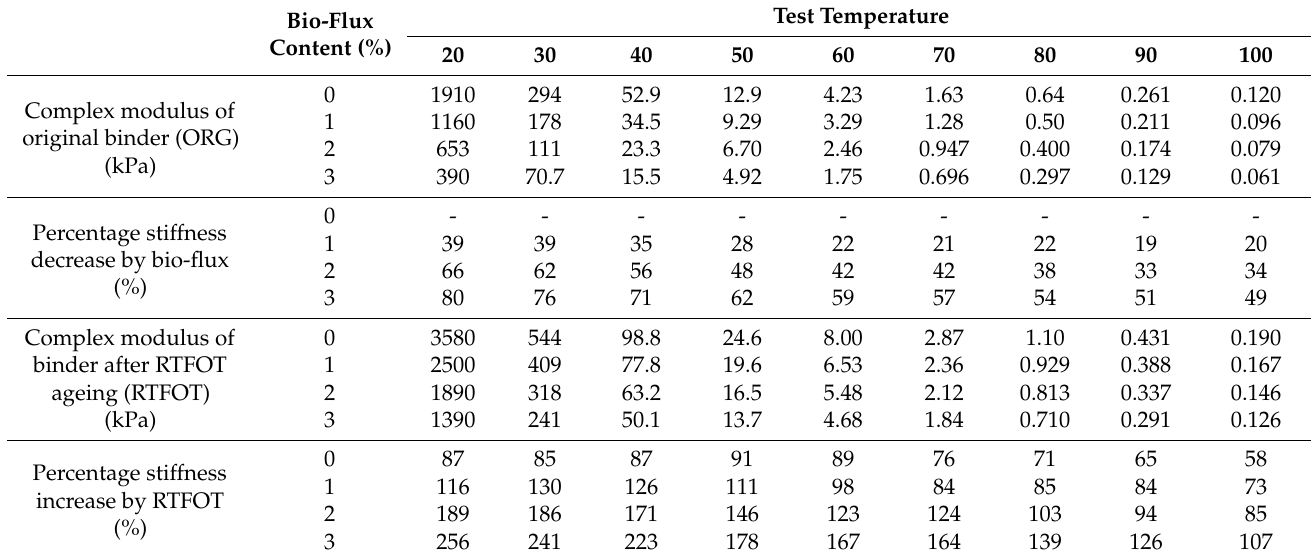
Table 4. Comparison of G* modulus results at 20 ◦ C for the 45/80–55 polymer-modified bitumen.